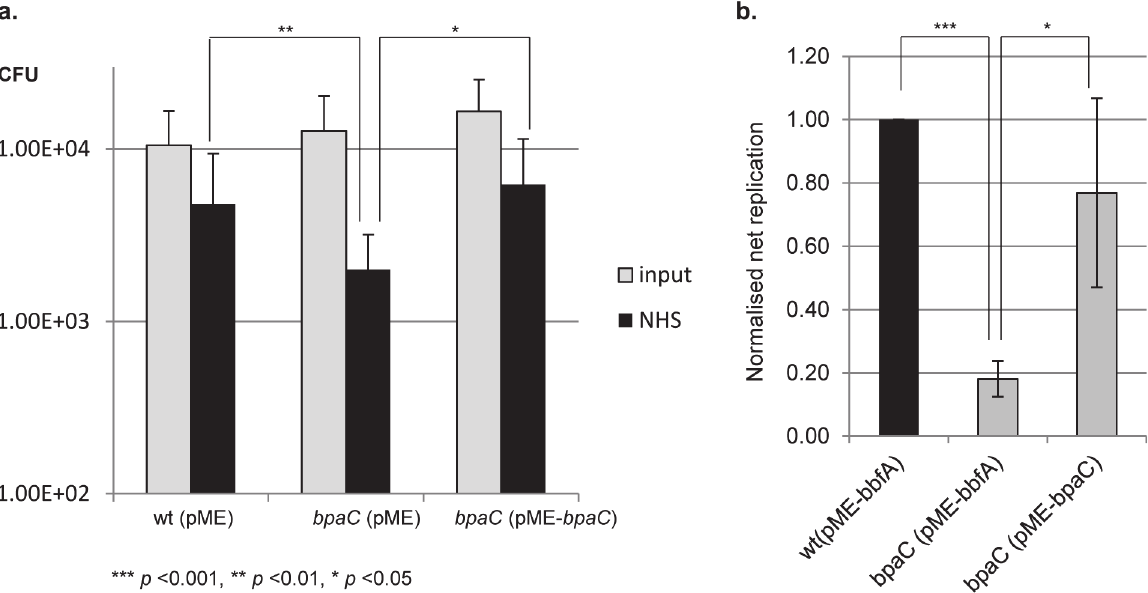
Fig 3. Complementation of the bpaC mutant serum sensitivity and intracellular survival phenotypes. a. Complementation of the bpaC mutant with a full-length copy of the bpaC gene expressed in trans by the inducible pME6032 vector (pME- bpaC ) abrogated the serum sensitive phenotype seen for the bpaC mutant harbouring empty pME6032 vector (pME). Graphs show mean results with error bars displaying standard error of the mean; statistical significance was calculated using Student ’ s t test. b. Complementation of the bpaC mutant with a full-length copy of the bpaC gene expressed in trans by the inducible pME6032 vector (pME- bpaC ) partially complemented the defect in net intracellular replication seen for the bpaC mutant harbouring pME6032 vector with a full-length copy of the bbfA gene (pME- bbfA ). Graphs show normalised mean results with error bars displaying standard error of the mean; statistical significance was calculated using Student ’ s t